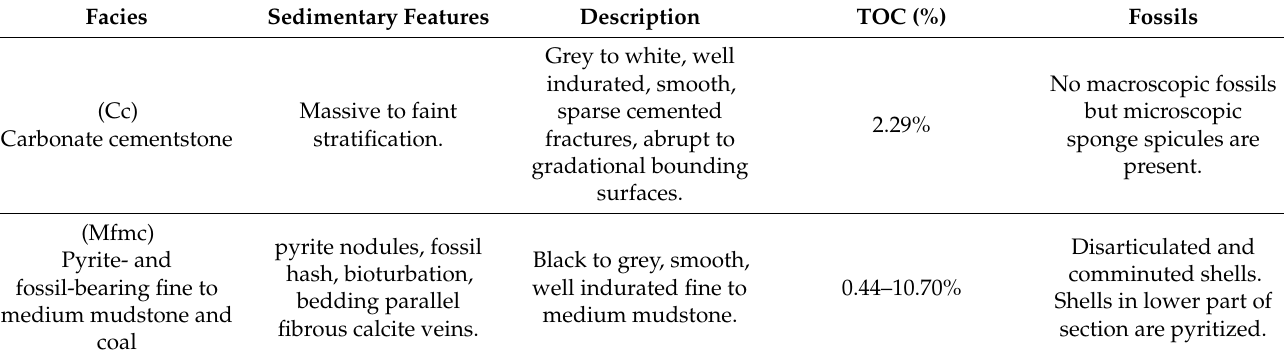
Table 3. Thirteen Finger limestone facies. Total organic carbon (TOC) data from TerraTek Schlumberger core services.